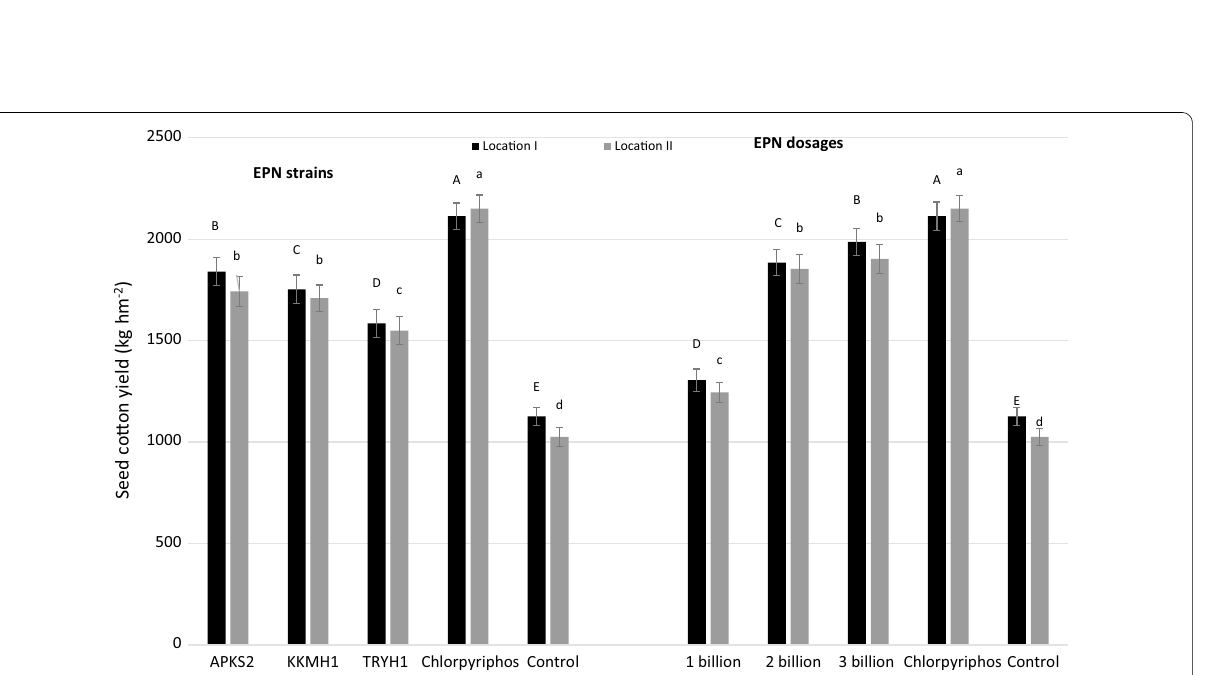
Fig. 2 Comparative performance of EPN strains as well as overall effect of three different concentrations of EPN on yield of cotton infested with Helicoverpa armigera (location 1) and Earias vittella (location II). Bars with the same letter do not differ significantly according to Tukey–Kramer test at P < 0.05. Capital letter represents field experiment I and small letter denotes field experiment